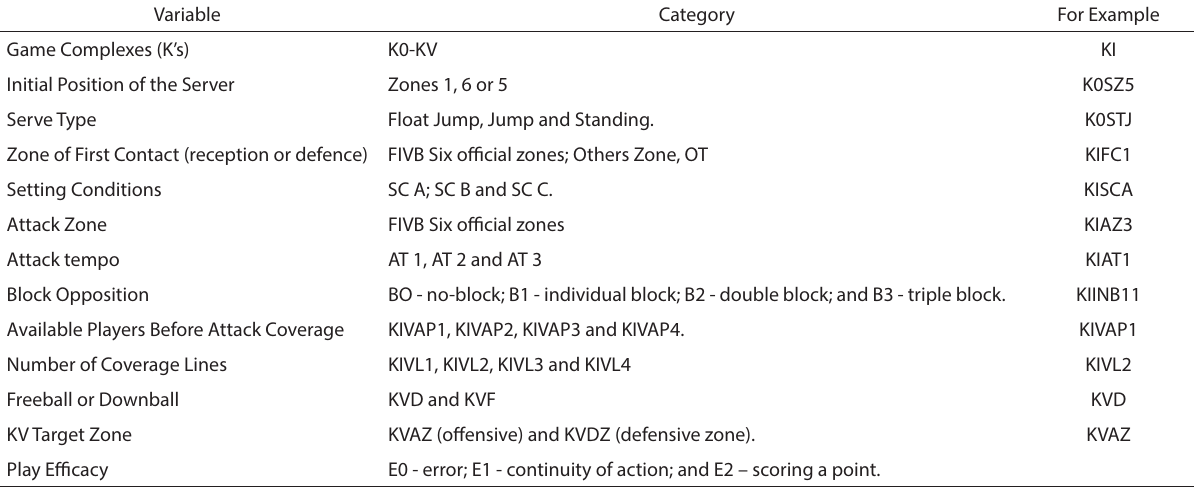
Table 1. Synthesis of variables, categories and codes